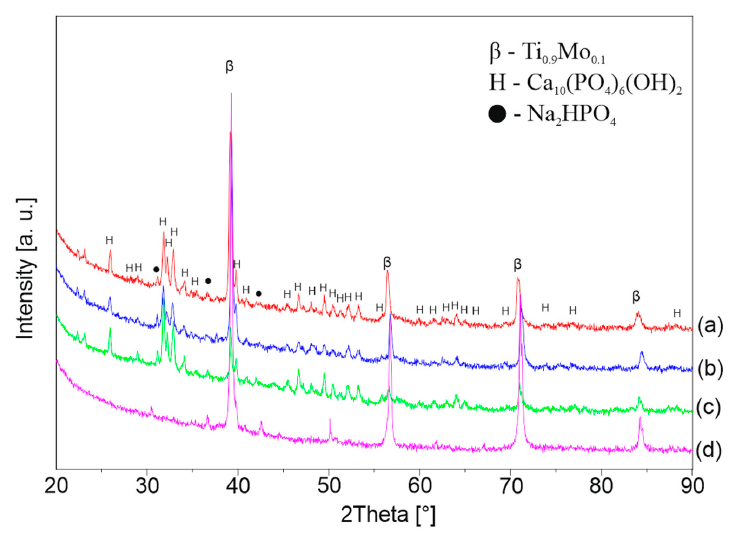
Figure 11. XRD patterns of ( a ) 27-5HT, ( b ) 27-7HT, ( c ) 27-10HT, ( d ) 27-12HT.